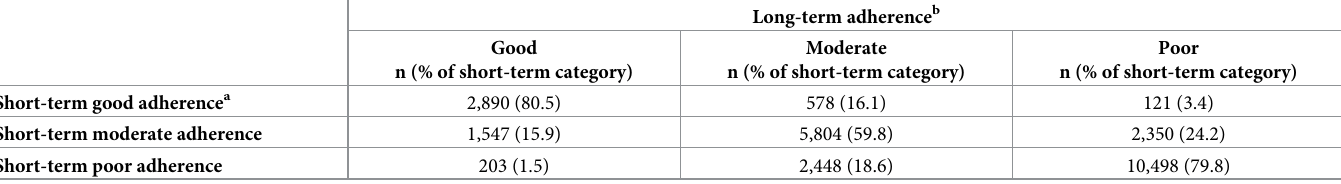
Table 4. Enrollees’ short-term and long-term adherence category, MarketScan 2008–2012 (N =